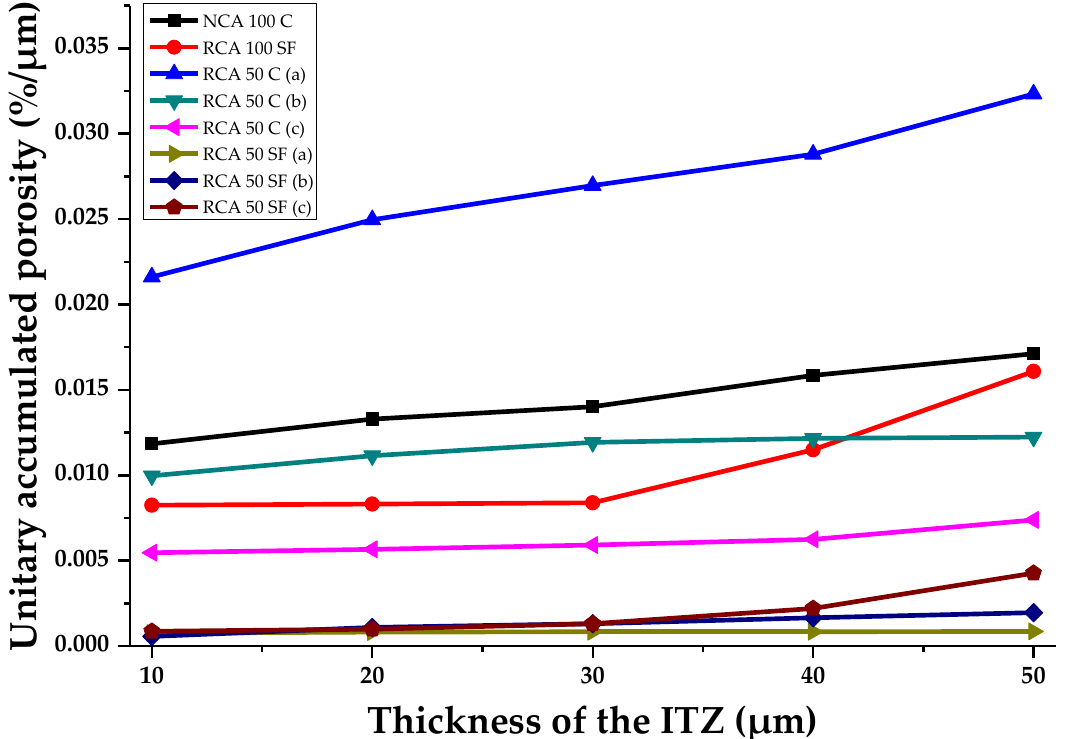
Figure 11. The porosity of the samples analyzed in the ITZ with several theoretical thicknesses.